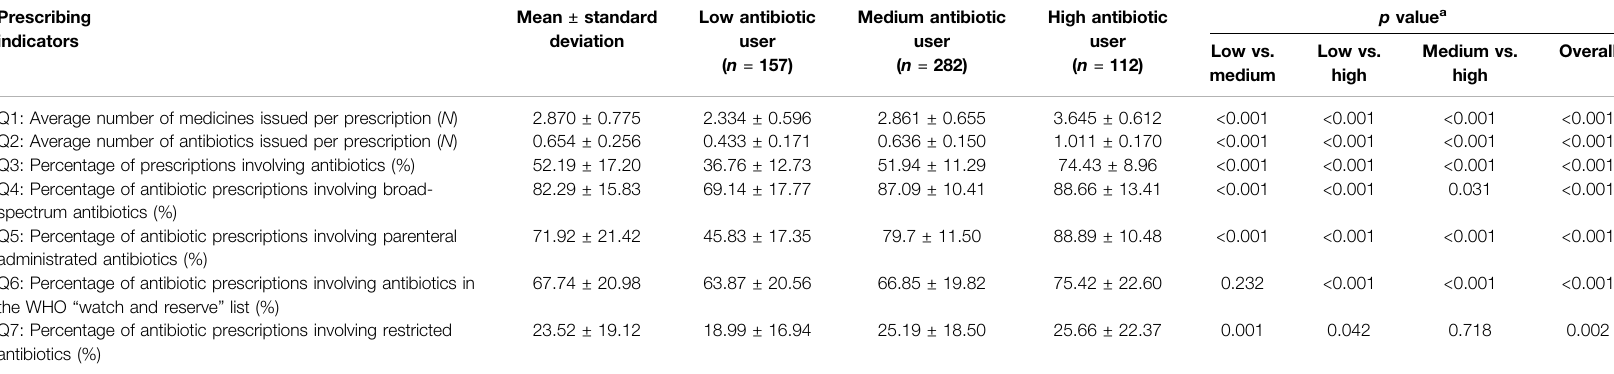
TABLE 1 | Prescribing patterns of primary care